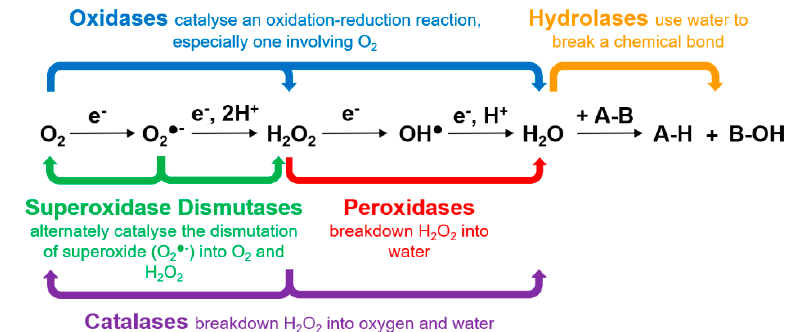
Figure 4. Schematic of the major reactions catalysed by oxidoreductases (oxidases, superoxide dismutases, peroxidases and catalases) and hydrolases.